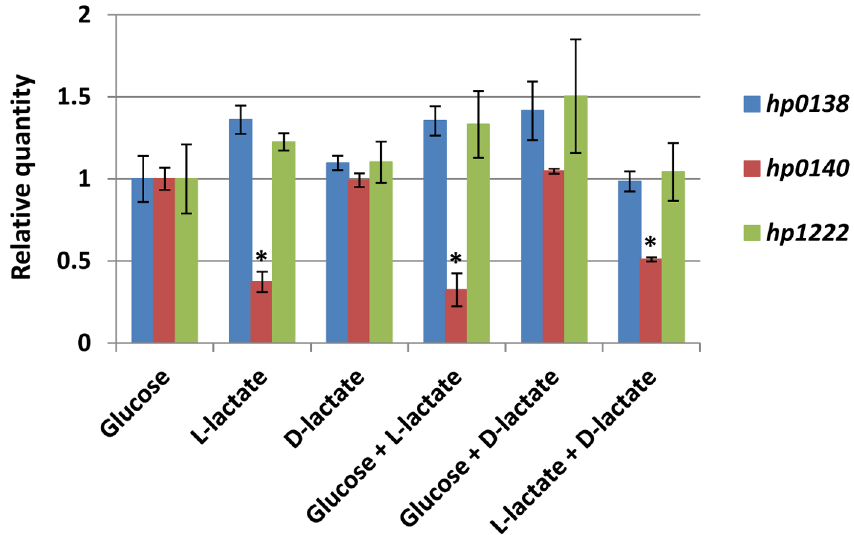
Figure 6. The relative gene expressions of hp0138 , hp0140 , and hp1222 in H.pylori 26695 wild type grown in a variety of carbon sources (5 mM glucose, 10 mM L-lactate, 10 mM D-lactate, 2.5 mM glucose + 5 mM L-lactate, 2.5 mM glucose + 5 mM D-lactate, or 5 mM L-lactate + 5 mM D-lactate). Real-time quantitative PCRs were performed in 7300 Real-Time PCR System (Applied Biosystems) using Taqman-designed primers and probes (Life technologies), and the data were analyzed by comparative Ct ( DD Ct) method with 16S rRNA as the reference gene. All the quantifications were performed in triplicate and were shown as the means 6 SD.